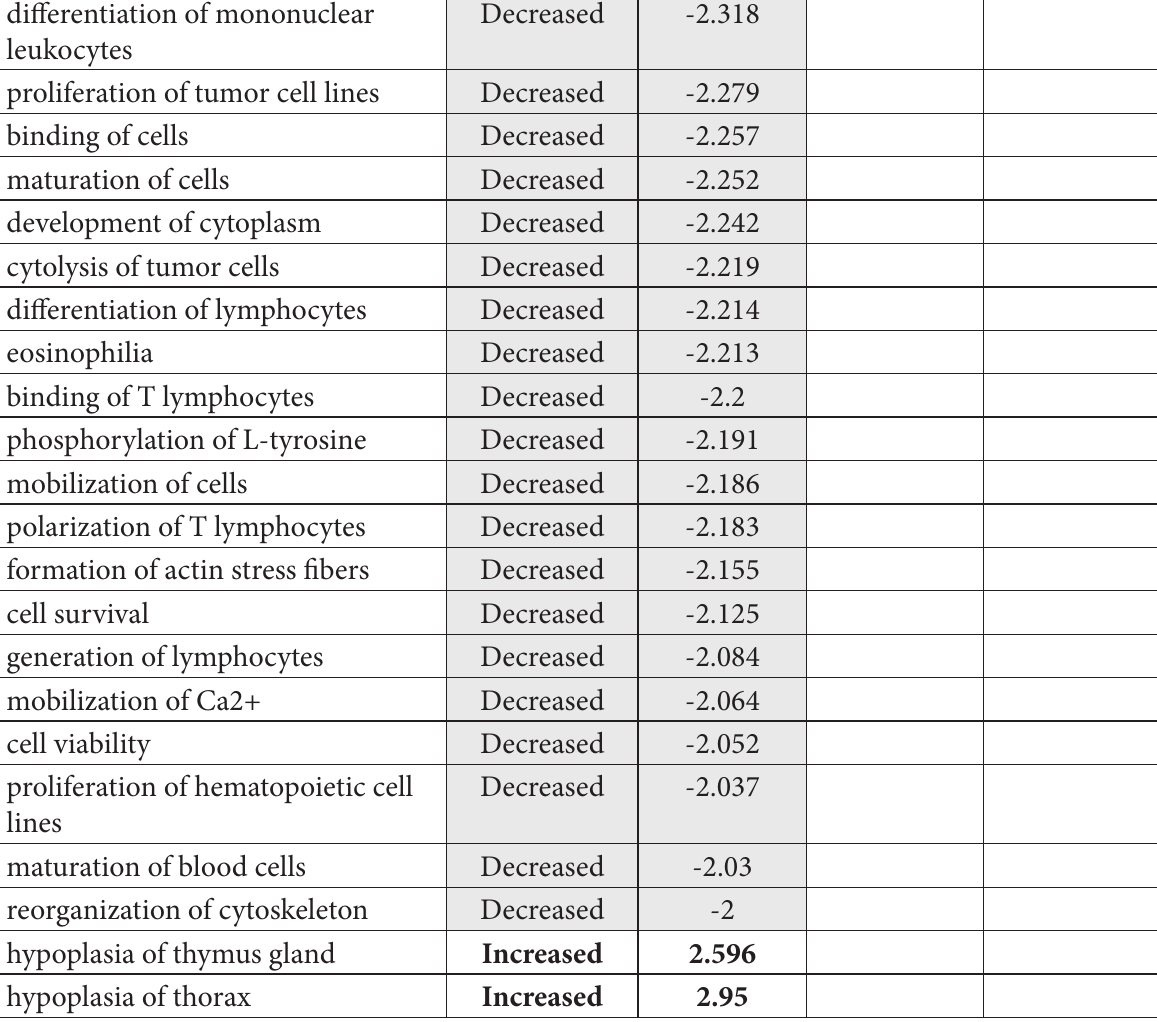
Table 7. Effect of atorvastatin on gene pathways that were significantly altered in HIV/ART compared to HIV-negative individuals at baseline